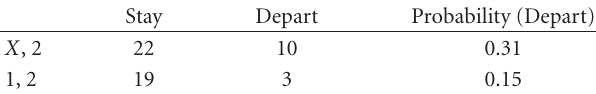
Table 1: Departure patterns of bumble bees on treated inflo- rescences of Aconitum columbianum. Four microliters of 30% sucrose solution were placed in bottom flowers of the inflorescence, with zero microliters (empty) in second-from-bottom flowers. The notation in this and all subsequent tables is X , 2 standing for bees that began by visiting the empty second flower first, without visiting the bottom flower. 1, 2 stands for bees visiting the treated bottom flower and then the empty second flower. Goodness of fit test for the null hypothesis of equal probability to depart: χ 2 = 4 . 67, P < . 01. Table 2: Departure patterns of bumble bees on treated inflo- rescences of Aconitum columbianum. Second replication of the experiment with four microliters of 30% sucrose solution placed in bottom flowers of the inflorescence, zero in second-from-bottom flowers. Goodness of fit test for the null hypothesis of equal probability to depart: χ 2 = 5 . 24, P < . 01. Table 3: Departure patterns of bumble bees on treated inflores- cences of Aconitum columbianum . Two microliters of 30% sucrose solution placed in bottom flowers of the inflorescence, zero in second-from-bottom flowers. χ 2 = 1 . 73, P > . 05 .